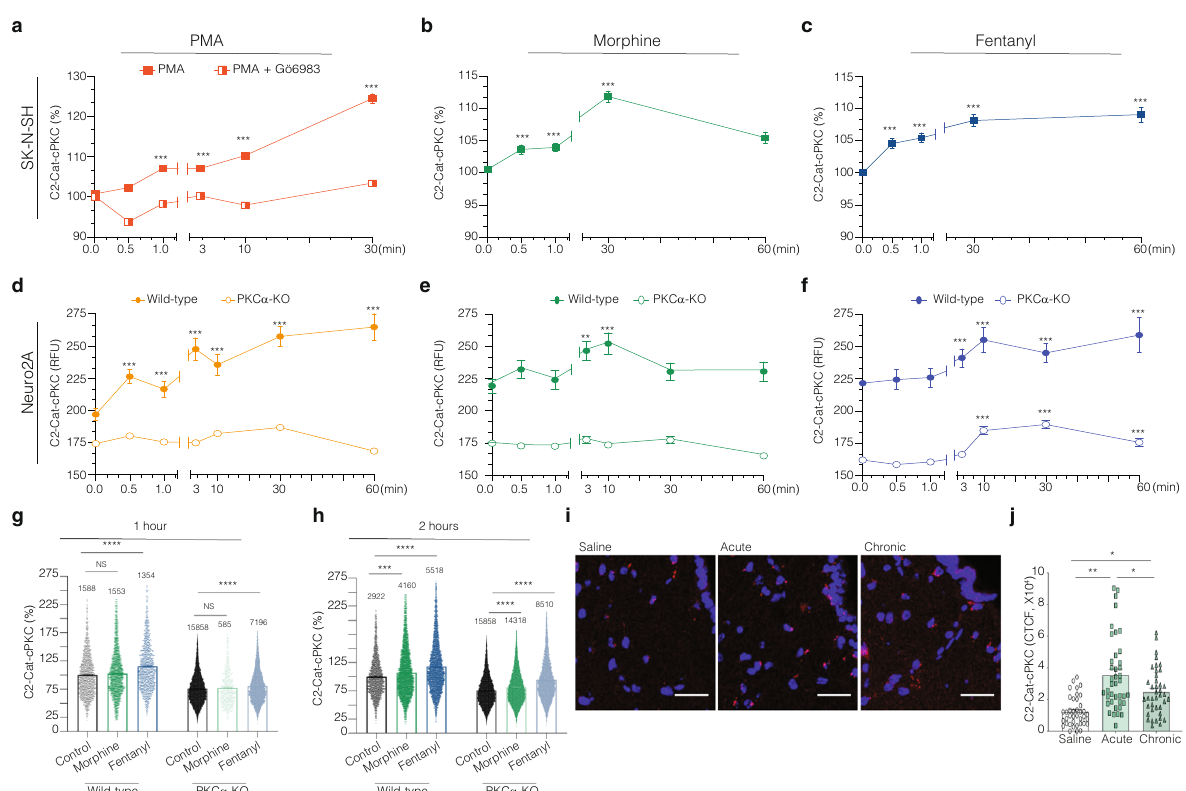
Fig. 6 Kinetics of cPKC activation mediated by morphine and fentanyl in cell lines and mice. Immuno fl uorescence analysis was carried out using the anti- C2-Cat-cPKC antibody (AVG459-D4). a – h Images were acquired with the InCell microscope, and the fl uorescence intensity obtained using the Cell Pro fi ler 3.1.5 software. a – c SK-N-SH cells were treated with PMA (500 nM) with and without Gö6983, 1 μ M ( a ), morphine, 1 μ M ( b ), and fentanyl, 1 μ M ( c ) for different time intervals. d – f Neuro2A and Neuro2A PKC α -KO cells were treated with PMA, 100 nM ( d ), morphine, 1 μ M ( e ), and fentanyl, 1 μ M ( f ) for different time intervals. *** p value < 0.001; **** p value < 0.0001; One-way ANOVA. Data are mean ± SE of two experiments, n = 400 – 40,000 cells. g , h Neuro2A and Neuro2A PKC α -KO cells were treated with morphine or fentanyl for 1 h ( g ) or 2 h ( h ). Bar graph, each dot represents one cell. Lines are mean ± SE of two experiments, number of counted cells are indicated. The percentage analysis used the mean of the integrated fl uorescence intensity from the non-treated Neuro2A cells as 100%. *** p value < 0.001; **** p value < 0.0001; One-way ANOVA. i , j cPKC activation in ventrolateral periaqueductal gray sections. Animals were administrated with saline, single injection of morphine (10 mg/kg), or chronic morphine – twice daily for 4 days. Mice were perfused with 4% paraformaldehyde for 30 min after fi nal injection. i Representative images of immuno fl uorescence using anti-C2-Cat-cPKC antibody (red) and DAPI (blue) are shown. j Corrected total cell fl uorescence of images in i were quantitated using ImageJ. Data are mean ± SE of one experiment, n = 40 sections/treatment, three animals each group; One-way